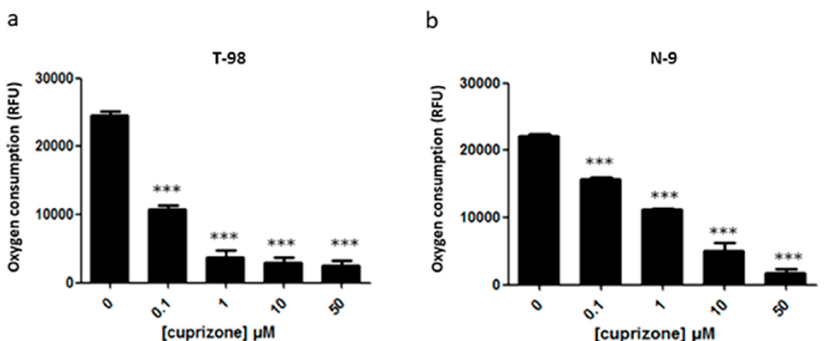
Figure 9. OCR assay in T-98 ( a ) and N-9 cells ( b ) incubated with increasing concentrations of CPZ (0.1–50 µ M) for 24 h. Data are the mean ± S.E.M of five independent experiments. Significant differences were analyzed by a one-way ANOVA followed by post-hoc Tukey’s test. *** p < 0.001 compared to control. RFU: relative fluorescence units.